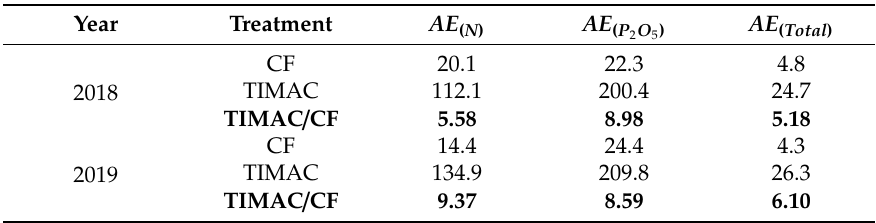
Table 6. Nutrient agronomic e ffi ciency of di ff erent treatments during experimental